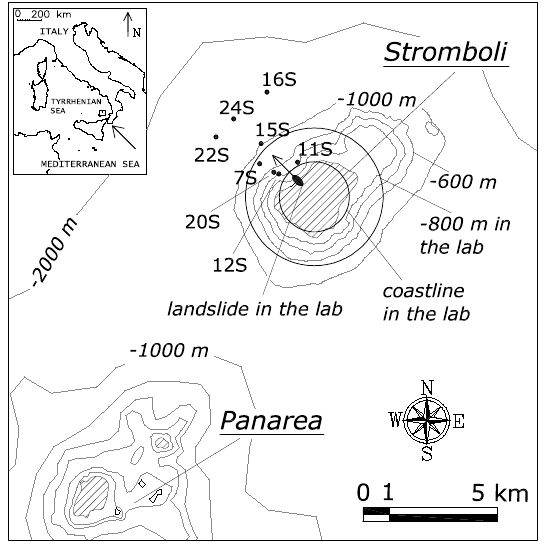
Fig. 3. Sketch of the bathymetry around Stromboli and Panarea islands (South Tyrrhenian Sea), where we have superimposed the layout of the physical model, with the gauges positions, scaled of 1000 times using the Froude law.